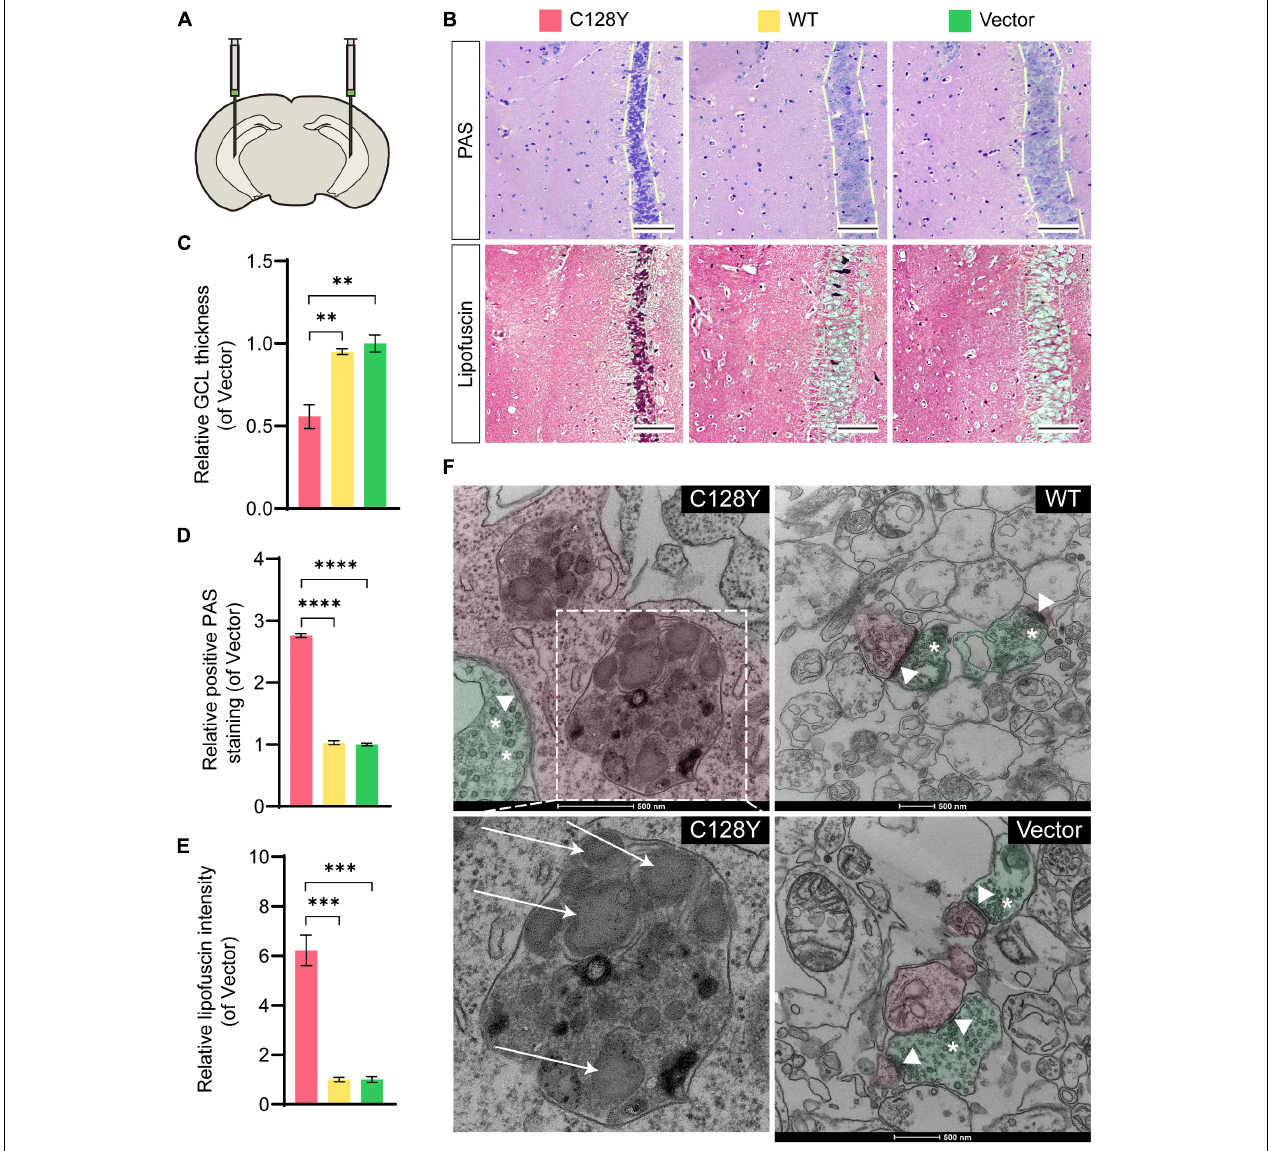
FIGURE 4 | Aberrant granule cell layer and PSDs as a result of the C128Y mutation in vitro. (A) Bilateral hippocampal CA3 was delivered with lentivirus to overexpress mutant or wild-type CSP α . (B) Representative pictures show the granule cell layer of the mutant-injected hippocampal CA3 region is thinner as quantified in panel C , and with PAS-positive storage material in the granule cell perikarya (quantified in panel D ), which was verified to be lipofuscin by the long Ziehl-Neelsen staining (quantified in panel E ). (F) A representative picture showed the ultrastructure of the hippocampal CA3 region, with pseudo-green used to highlight the structure of a presynaptic neuron, and with pseudo-red demonstrating a postsynaptic neuron. C128Y mutation induced the enlargement of the lysosome compartment filled with heterogeneous contents, mainly the GRODs (white arrow), and the PSD (arrowheads) decreased remarkably. N = 3, all data in the figure are shown as mean ± SEM, each group vs. vector. ∗ P < 0.05, ∗∗ P < 0.01, ∗∗∗ P < 0.001, and ∗∗∗∗ P < 0.0001. White arrows: GRODs; arrowheads: PSD; asterisks: synaptic vesicles. GRODs, granular osmiophilic deposits; PSD, postsynaptic